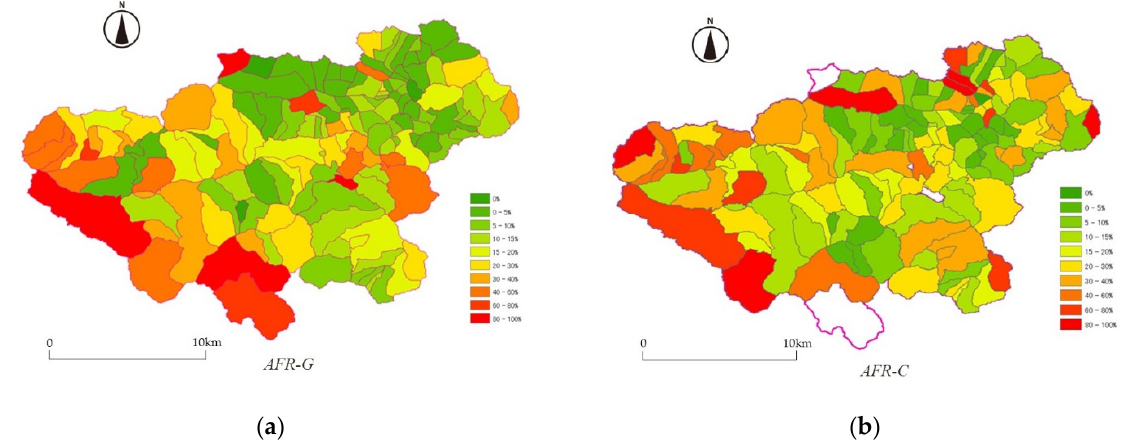
Figure 4. Distribution of abandoned farmland rate. ( a ) AFR-G and ( b ) AFR-C.